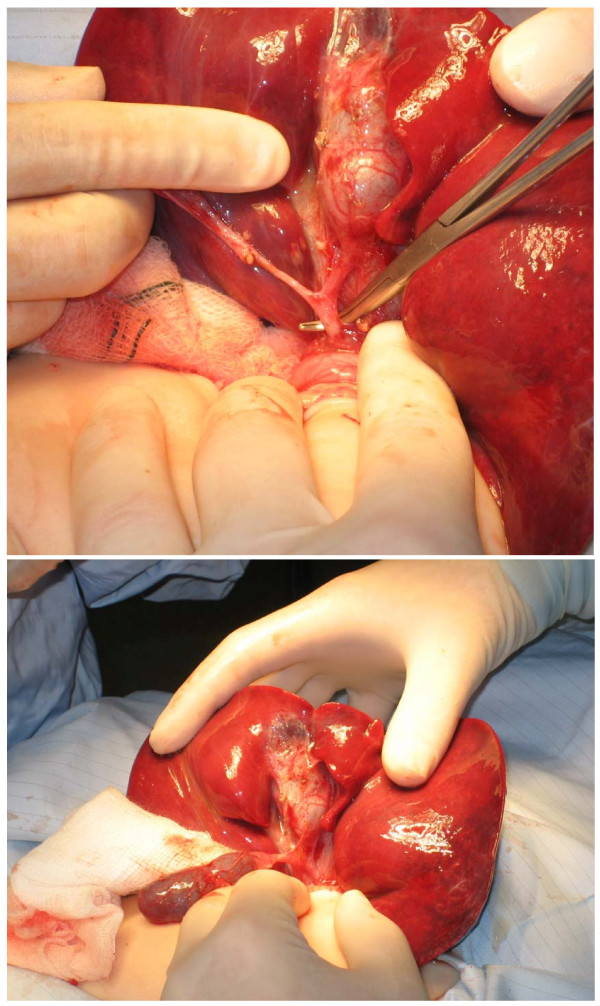
Operative findings.